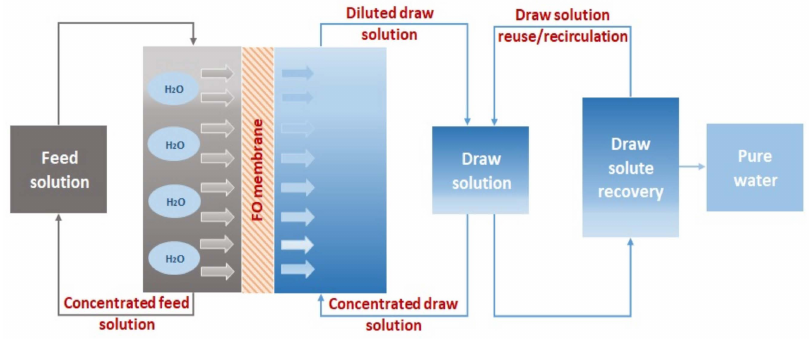
Figure 3. Schematic diagram of a FO process